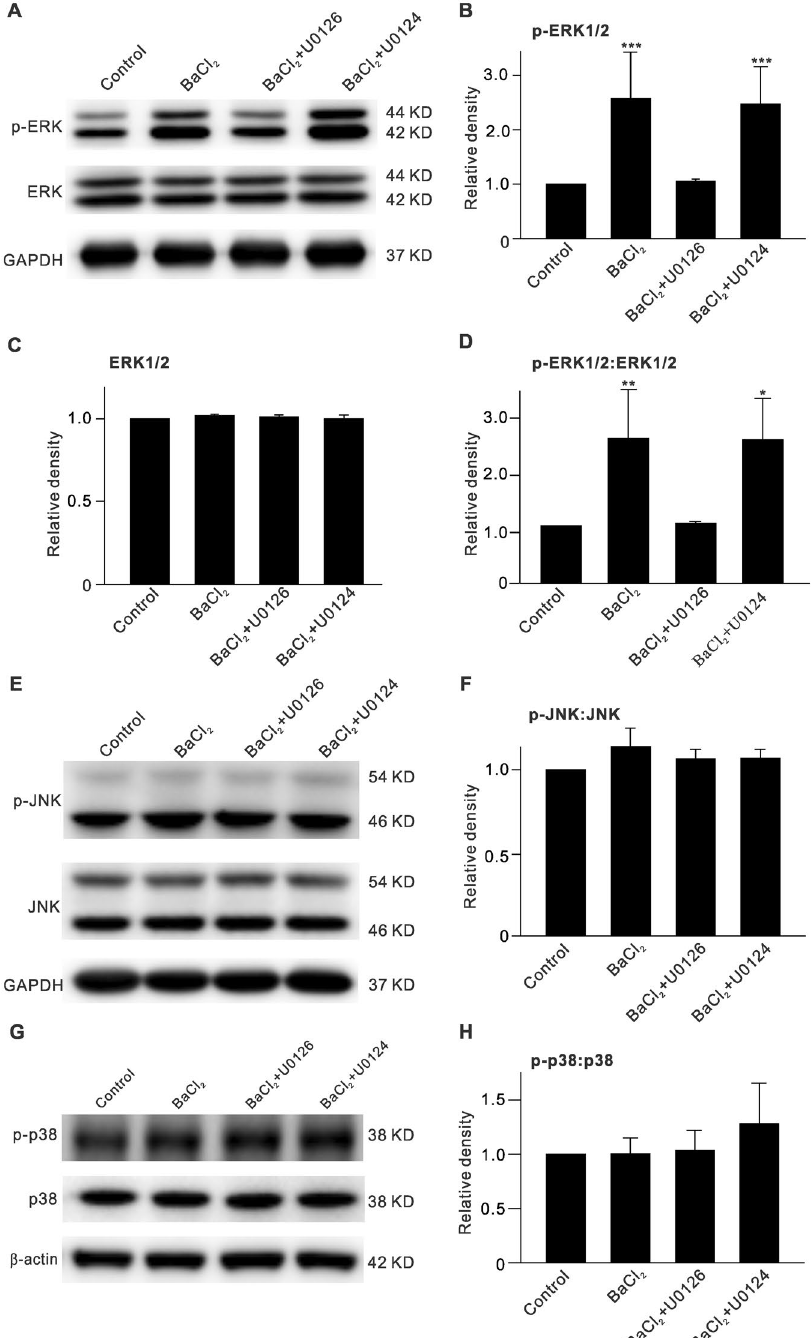
Figure 2. Increase of p-ERK expression in BaCl 2 -injected retinas. ( A ) Representative immunoblots showing changes in p-ERK1/2 and ERK1/2 levels in vehicle (Control)-, BaCl 2 -, BaCl 2 + U0126- or BaCl 2 + U0124- injected retinas, respectively. ( B , C ) Bar charts summarizing the average densitometric quantification of immunoreactive bands of p-ERK1/2 ( B ) and ERK1/2 ( C ) protein expression under different conditions. ( D ) Bar charts summarizing the average p-ERK1/2:ERK1/2 ratios under different conditions. n = 6 all each group. * P < 0.05 and ** P < 0.01 vs . Control. ( E , G ) Representative immunoblots showing changes in p-JNK and JNK levels ( E ), p-p38 and p38 ( G ) levels in vehicle (Control)-, BaCl 2 -, BaCl 2 + U0126- or BaCl 2 + U0124-injected retinas, respectively. ( F , H ) Bar charts summarizing the average p-JNK:JNK and p-p38:p38 ratios under different conditions. Note that inhibition of Kir channels by injecting BaCl 2 did not affect p-JNK and p-p38 levels. n = 6 all each